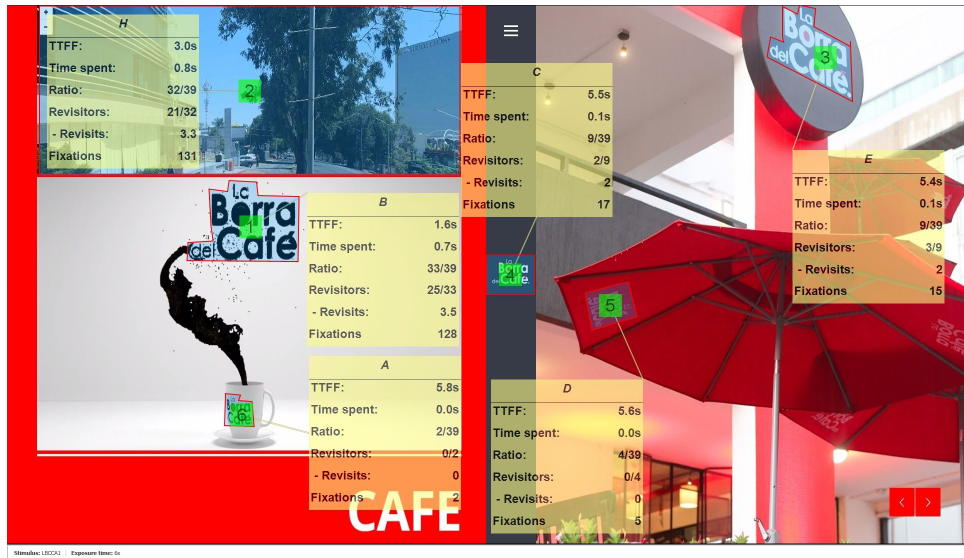
Figure 1. New website design—denoted as dynamic website design and on-stimulus—with 6 areas of interest (AOI) metrics. Note: time to first fixation (TTFF). (1) Brand name in black font within animation; (2) company branch location preview; (3) brand name in white font in company sign; (4) brand name in white font; (5) brand name in white font in company umbrella; (6) brand name in black font in cup with animation. Note: Table A4 contains the same metrics for a more readable option.